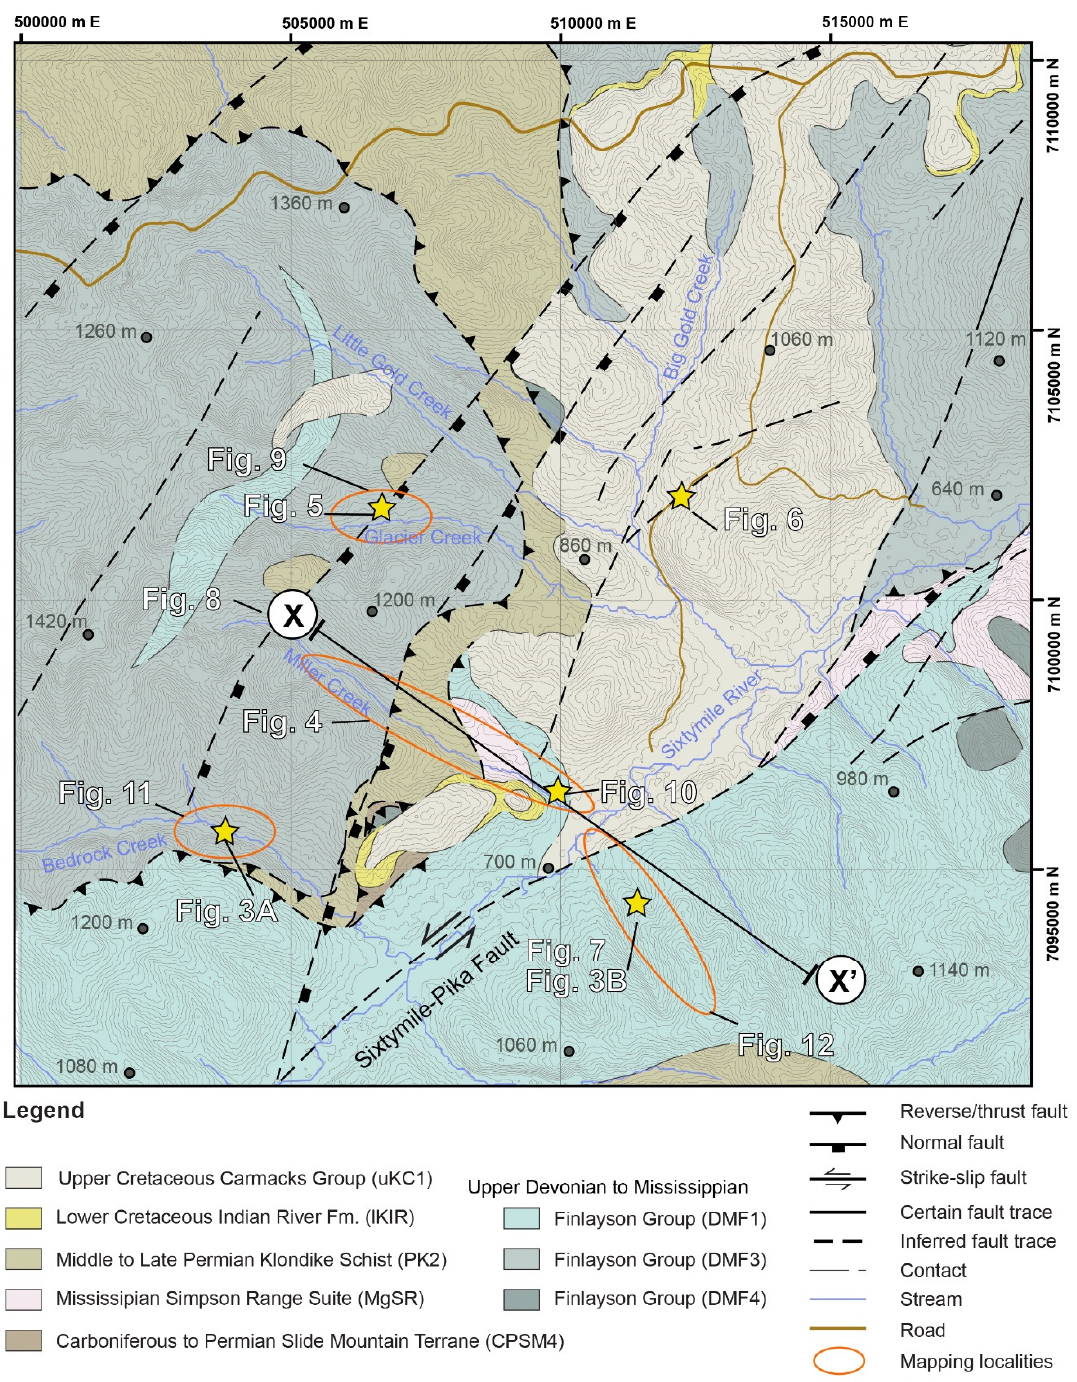
Figure 2. Local geology of the Sixtymile area which consists of a range of units which span the Mesozoic and Paleozoic (modified after maps by Mortensen, 1996, and the Yukon Geological Survey, 2020) [18,23]. Abbreviations of geological formations are from the Yukon Geological Survey (2020). Contour interval is 20 m.